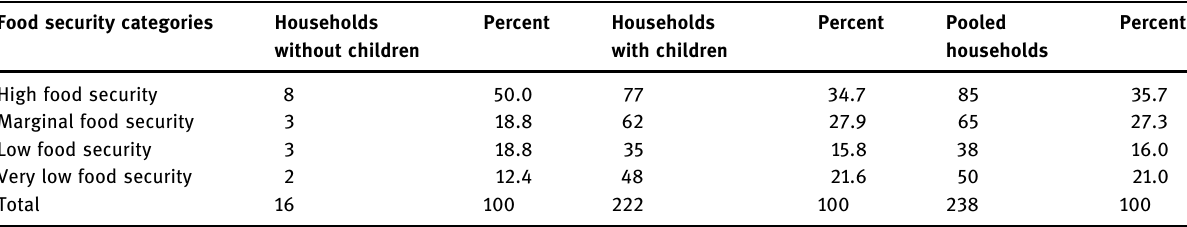
Table 4: Classi fi cation of respondents ’ household according to food security status Food security